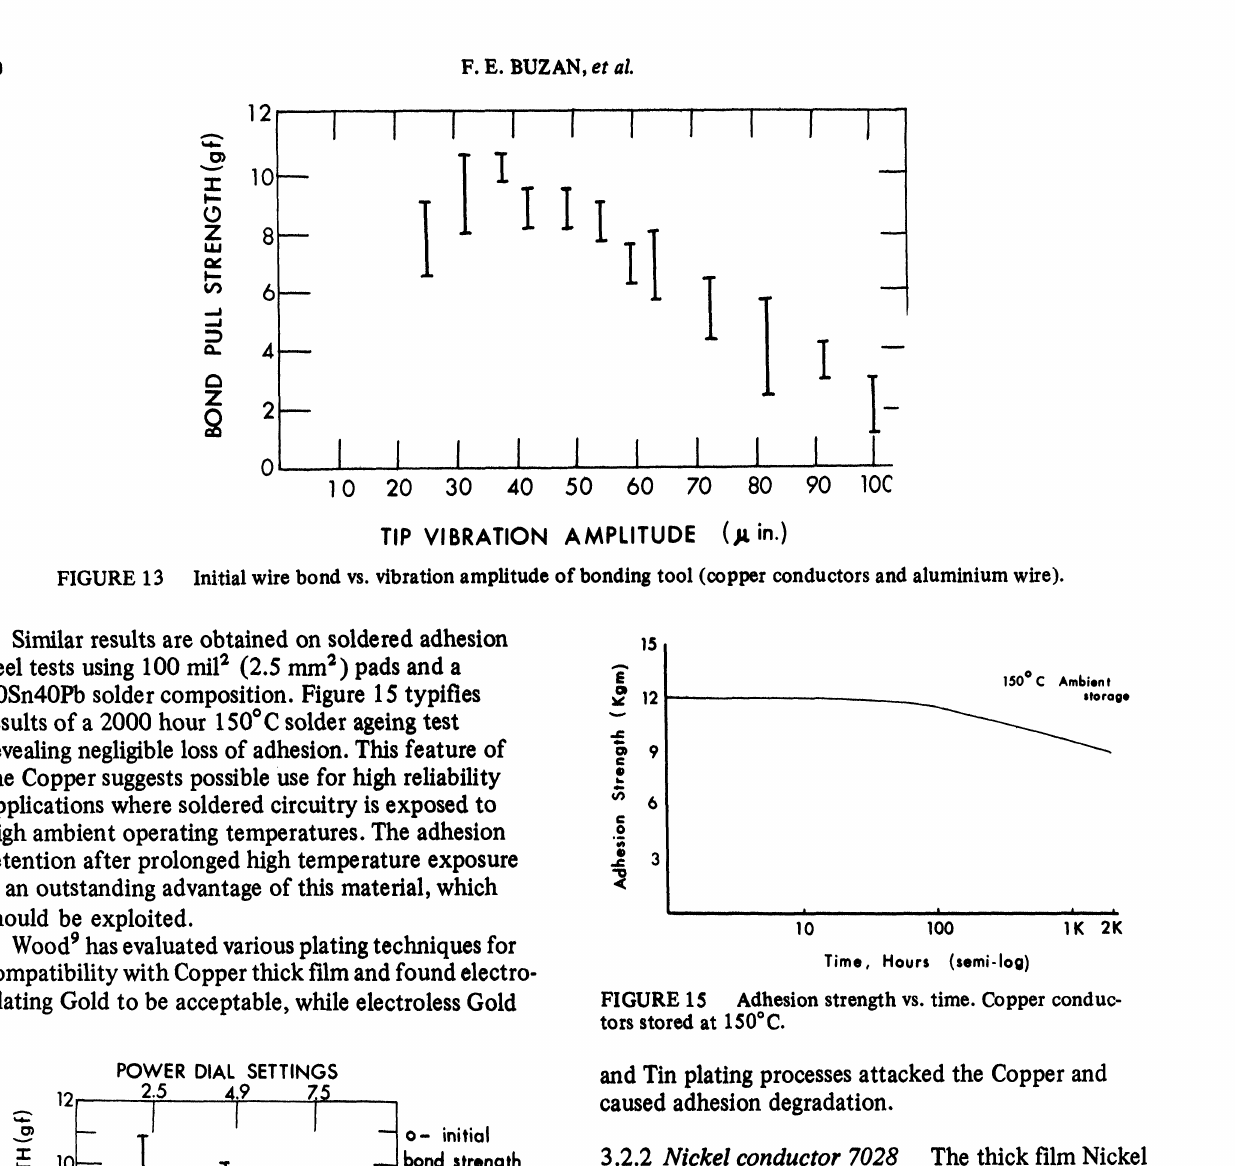
Adhesion strength vs. time. Copper conduc- tors stored at 150 C.